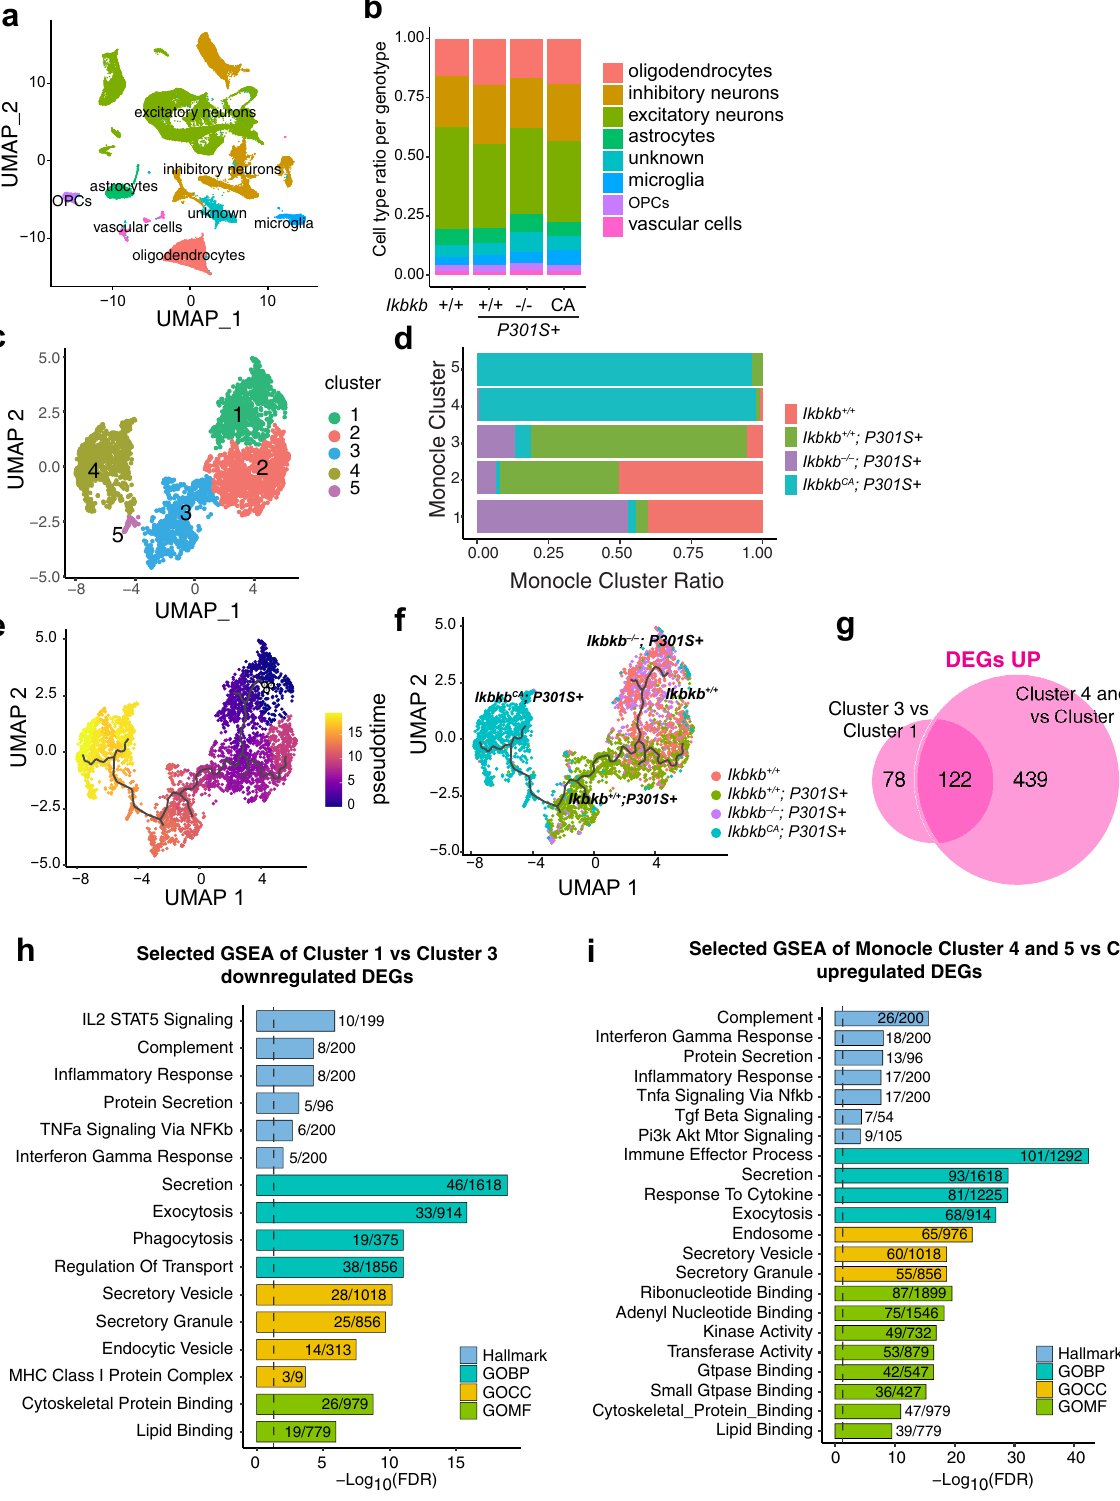
activity is necessary for executing tau-mediated neuronal toxicity and cognitive de fi cits. Taken together, our work shows that microglial NF- κ B acts downstream of tau pathology, and directly mediates toxic effects on cognition, highlighting the potential of blocking maladaptive microglial responses instead of removing tau aggregates as a therapeutic strategy to treat